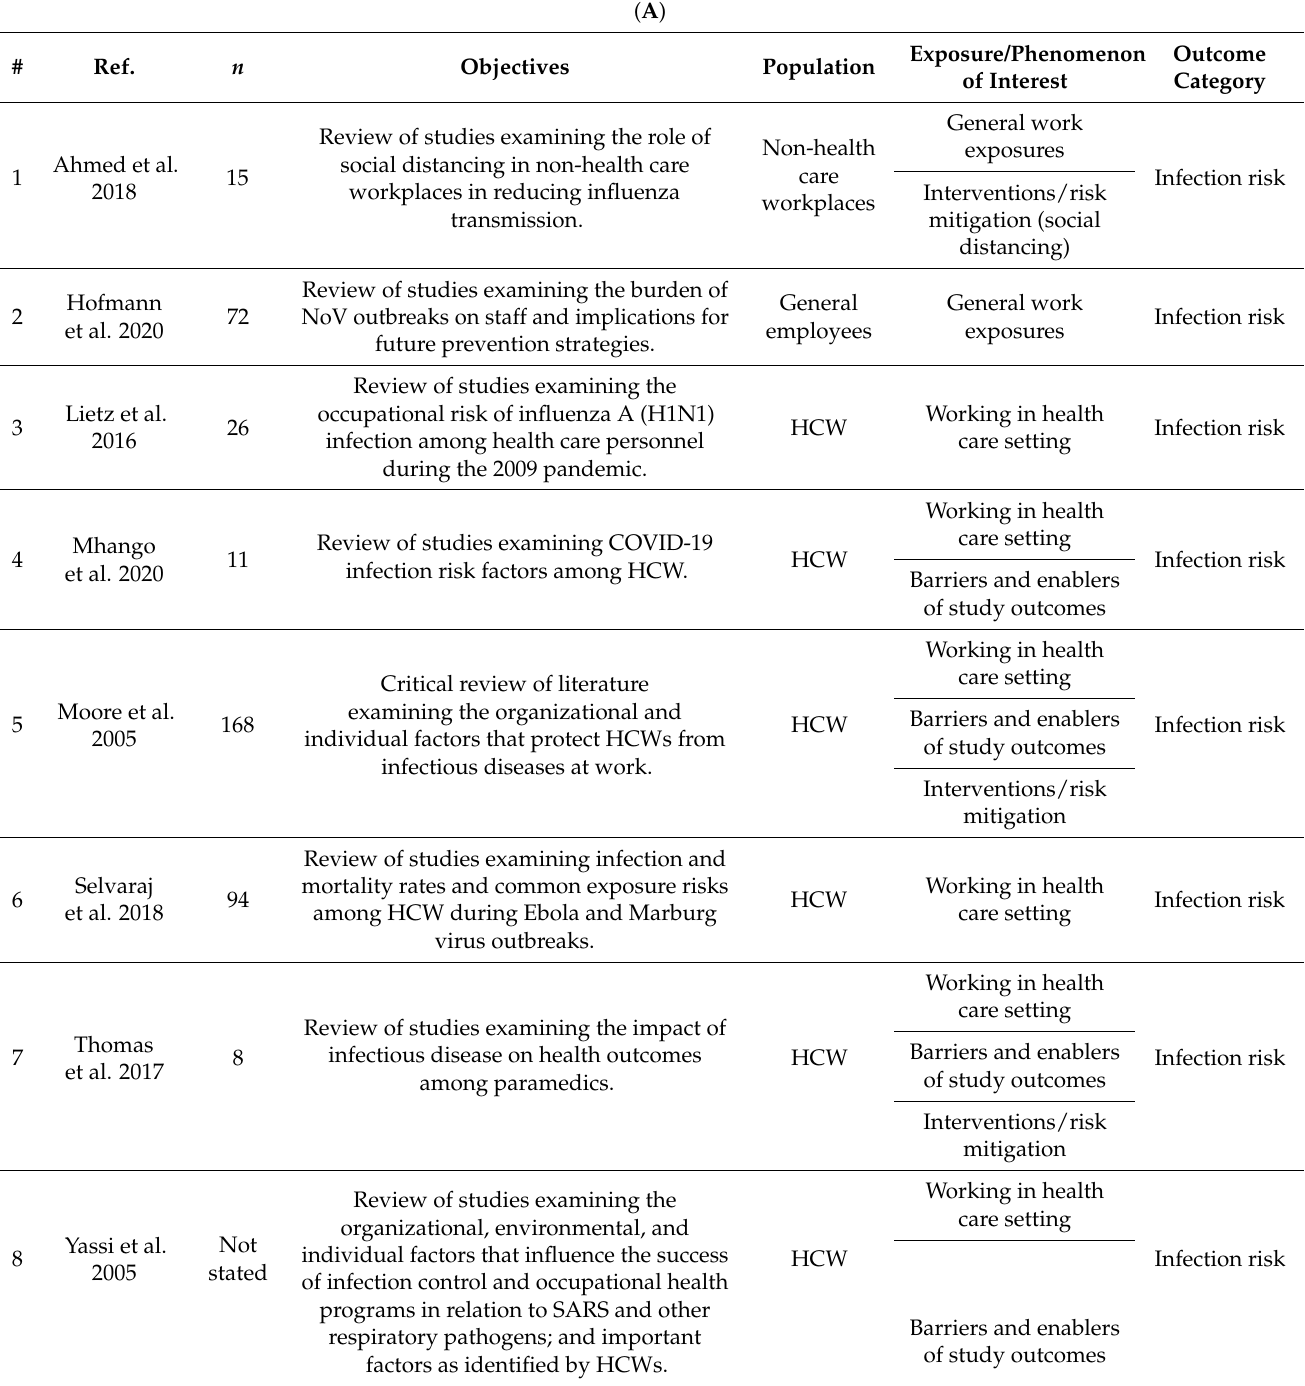
Table 1. ( A ) Characteristics of included systematic reviews that examined infection risk outcomes. ( B ) Characteristics of included systematic reviews that examined mental illness and well-being outcomes. ( C ) Characteristics of included systematic reviews that examined disaster response and preparedness outcomes. ( D ) Characteristics of included systematic reviews that examined a mix of